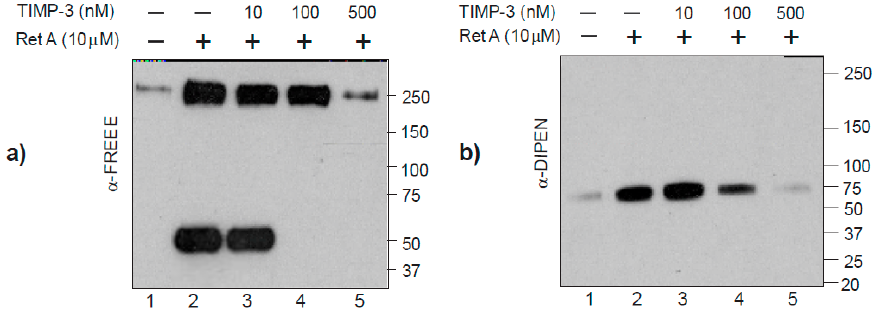
Figure 4. The novel aggrecanase is inhibited by tissue inhibitor of metalloproteinase (TIMP)-3. Western blot analyses show that TIMP-3 inhibits retinoic acid-induced aggrecanolysis at FREEE 1467 ↓ 1468 GLGSV ( a ) and DIPEN 341 ↓ 342 FFGVG ( b ) in TS-4/5 Δ cat cartilage explants.